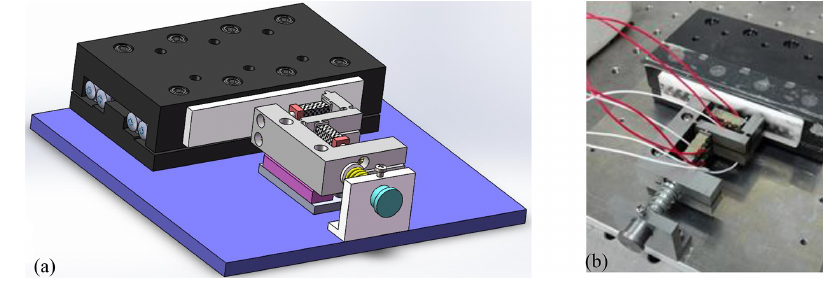
Figure 15. Precision linear positioning platform. (a) 3D model; (b)